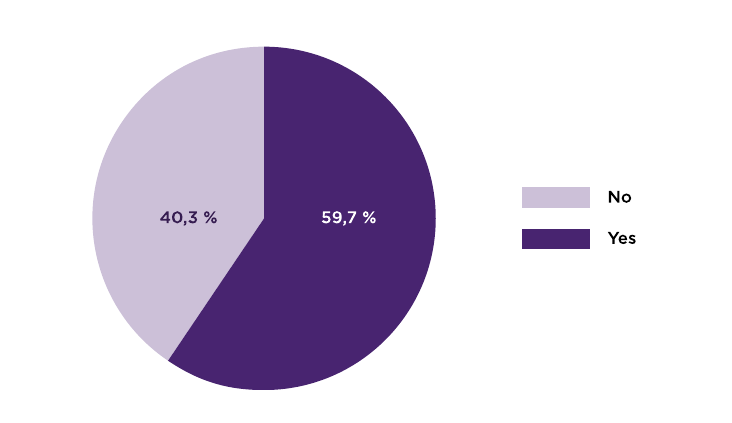
European Diploma